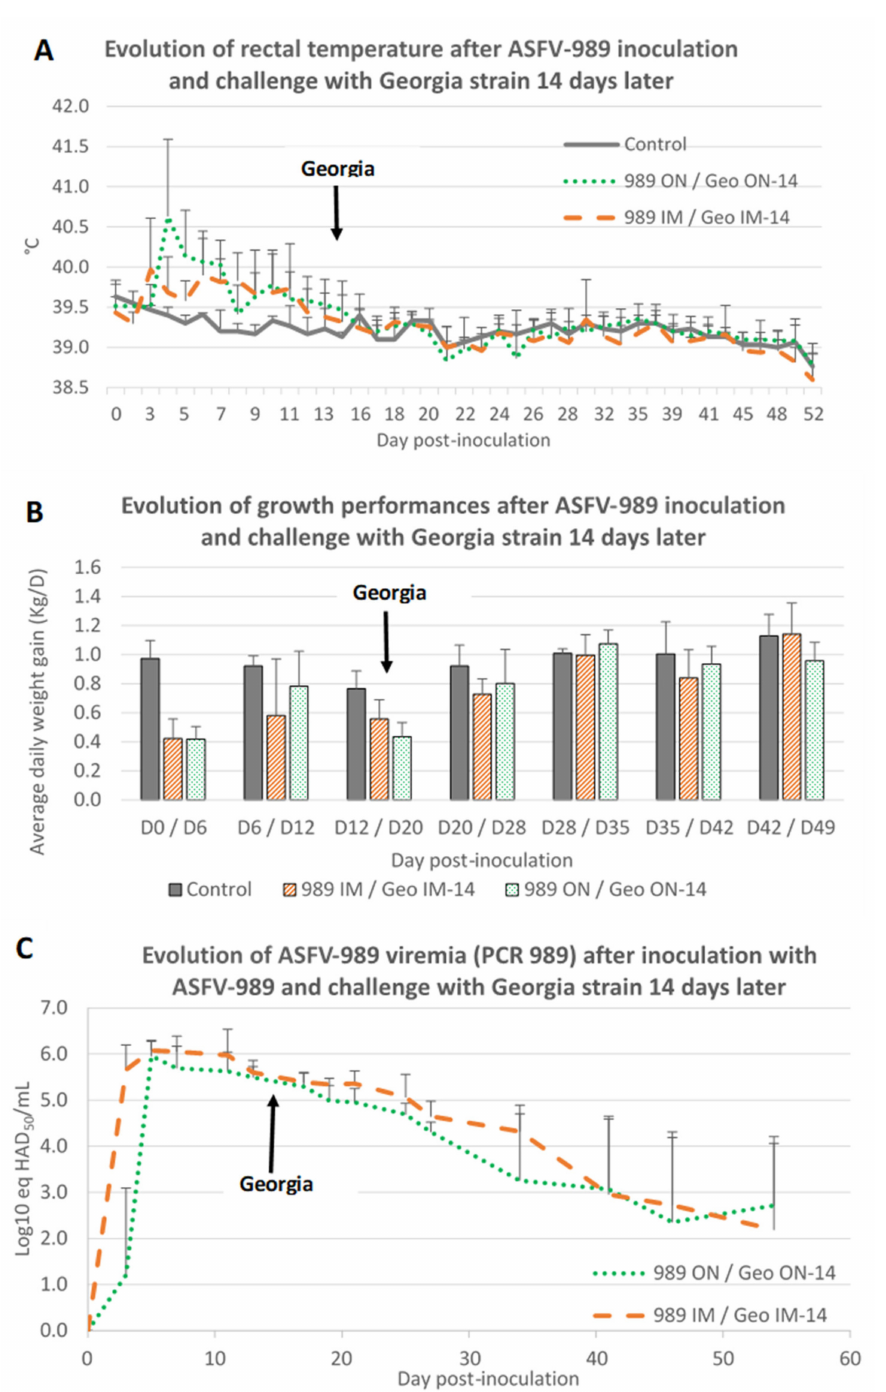
Figure 7. Evolution of rectal temperature, growth performance, and ASFV viremia after ASFV- 989 inoculation and Georgia challenge occurring 14 days after inoculation. ( A ) Evolution of rectal temperature ( ◦ C) (time in days post-inoculation). ( B ) Evolution of growth performance: average daily weight gain (Kg/D) (time in days post-inoculation). ( C ) Evolution of ASFV viremia (PCR 989, Log10 eq HAD 50 /mL) (time in days post-inoculation). Control—data from group A3; 989 IM/Geo IM-14—data from group K; 989 ON/Geo ON-14—data from group